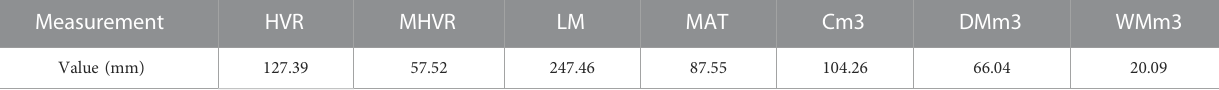
Ursus arctos (IVPP OV 2103), are from fi rst-hand measurements, and other comparative data are derived from Therrien (2005) ( Panthera leo , Crocuta crocuta , and Canis lupus ), Hunt (2011) ( Temnocyon macrogenys , Delotrochanter oryktes , and Borocyon robustum ), and Morales et al. (2021a) ( Ammitocyon kainos and Magericyon anceps ).